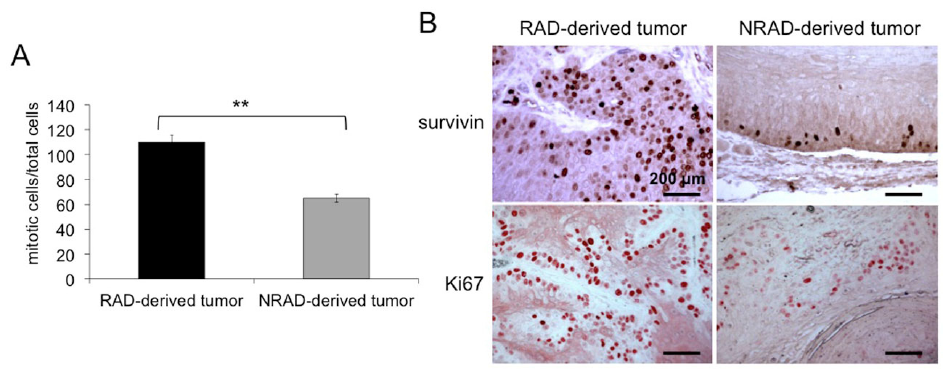
Figure 7. RAD and NRAD-derived tumor characterization. ( A ) Mitotic Index representing the number of cells undergoing mitosis over total cells were counted in RAD and NRAD-derived tumors ** p < 0.01; ( B ) Survivin and Ki67 expression in RAD and NRAD-derived tumors by immunohistochemistry. Scale bar = 200 μ m; ( C ) K10, E-FABP and involucrin expression in RAD and NRAD-derived tumors by immunohistochemistry. Scale bar = 200 μ